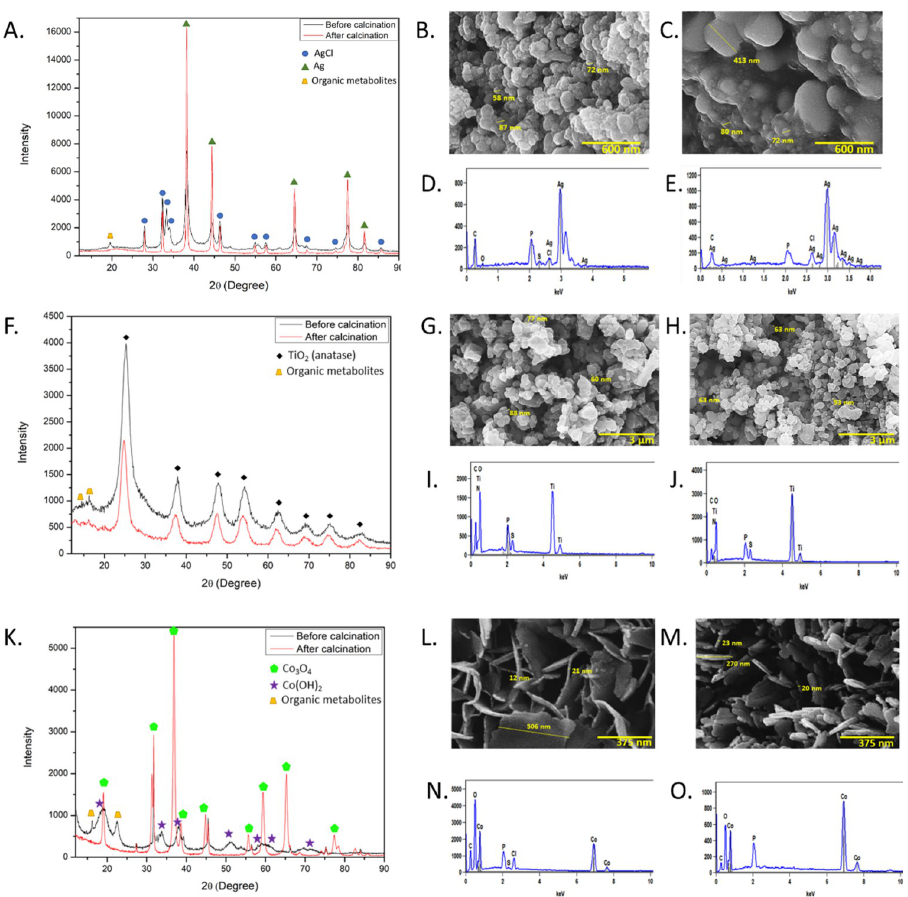
Fig 4. Crystallographic and microscopic studies of prepared nanomaterials. (A) XRD spectrum of Ag NPs, (B) SEM image of Ag NPs before calcination, (C) SEM image of Ag NPs after calcination, (D) EDX of Ag NPs before calcination, (E) EDX of Ag NPs after calcination, (F) XRD spectrum of TiO2 NPs, (G) SEM image of TiO2 NPs before calcination, (H) SEM image of TiO2 NPs after calcination, (I) EDX of TiO2 NPs before calcination, (J) EDX of TiO2 NPs after calcination, (K) XRD spectrum of Co(OH)2 NM and Co3O4 NM, (L) SEM image of Co(OH)2 NM (before calcination), (M) SEM image of Co3O4 NM (after calcination), (N) EDX of Co(OH)2 NM (before calcination), (O) EDX of Co3O4 NM (after